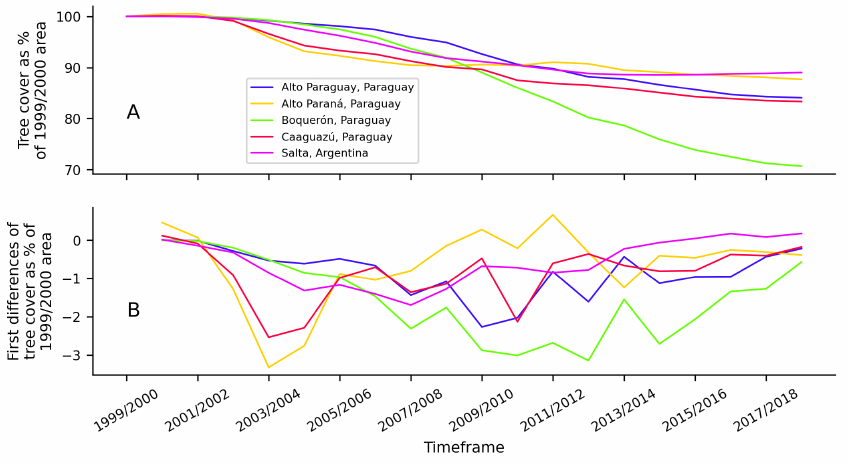
Figure A4. Tree cover area from 1999/2000 to 2018/2019 as a percentage of 1999/2000 tree cover for selected Southern Cone provinces (Argentina) and departments (Paraguay). The top panel ( A ) shows change in percent tree cover area from the 1999/2000 baseline. The bottom panel ( B ) shows the first differences in the change in percentages over time.